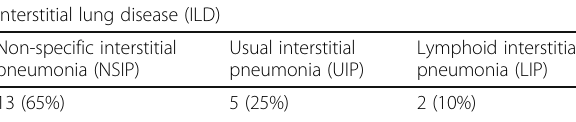
Table 7 Description of PFTs